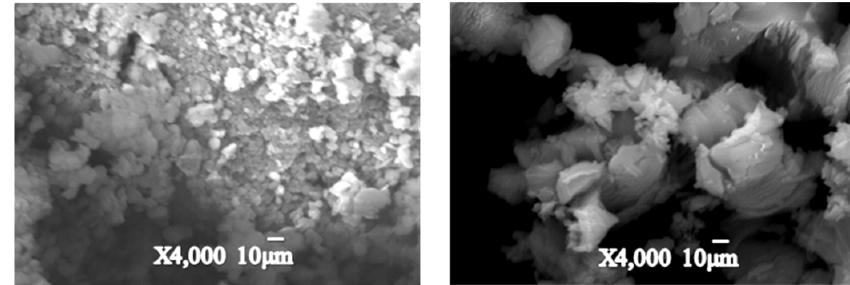
Processes 2022 , 10 , x FOR PEER REVIEW Figure 1. SEM results of light-burnt CaO and dead-brunt CaO. Figure 1. SEM results of light-burnt CaO and dead-brunt CaO.